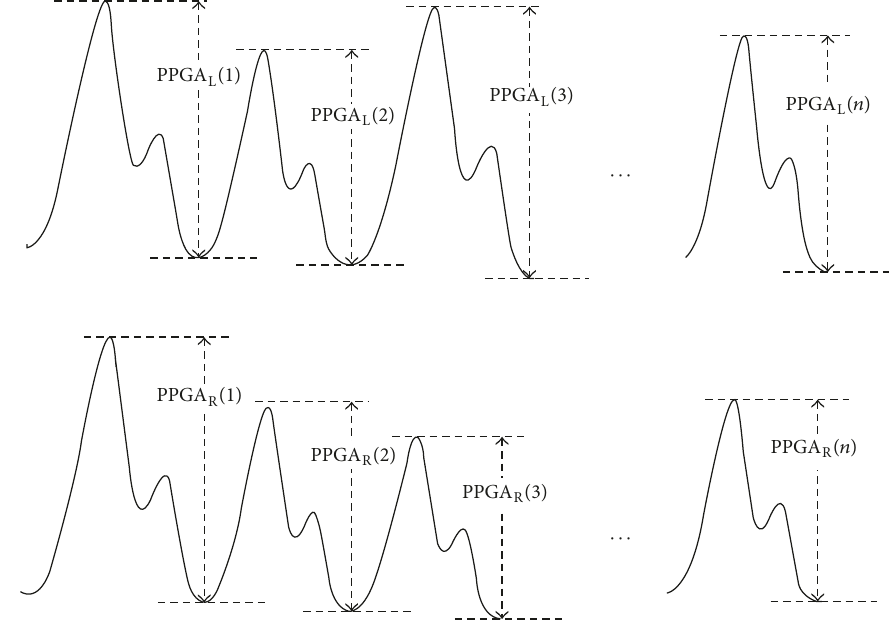
Figure 1: Photoplethysmographic pulse amplitudes (PPGA) series of left and right hands (PPGA L and PPGA R , resp.) were defined as the distance between peak and triumph of each pulse waveform and simultaneously acquired from signal 1 to signal 1,500.